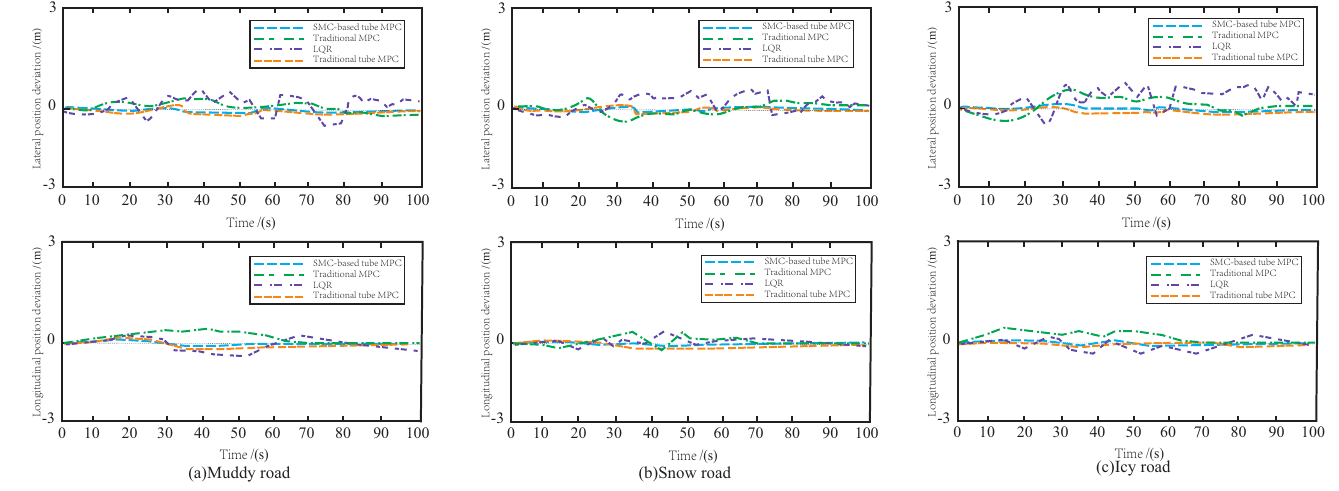
Figure 13. The variation of tracking error on the three roads. After testing on three types of roads, the average cycle time of the proposed algorithm is shown in Table 7. It can be seen that due to the low dimension of the system, the calculation efficiency of nominal MPC is very fast and remains at about 38 ms, while the calculation efficiency of SMC is even higher. The minimum time is only about 2 ms,